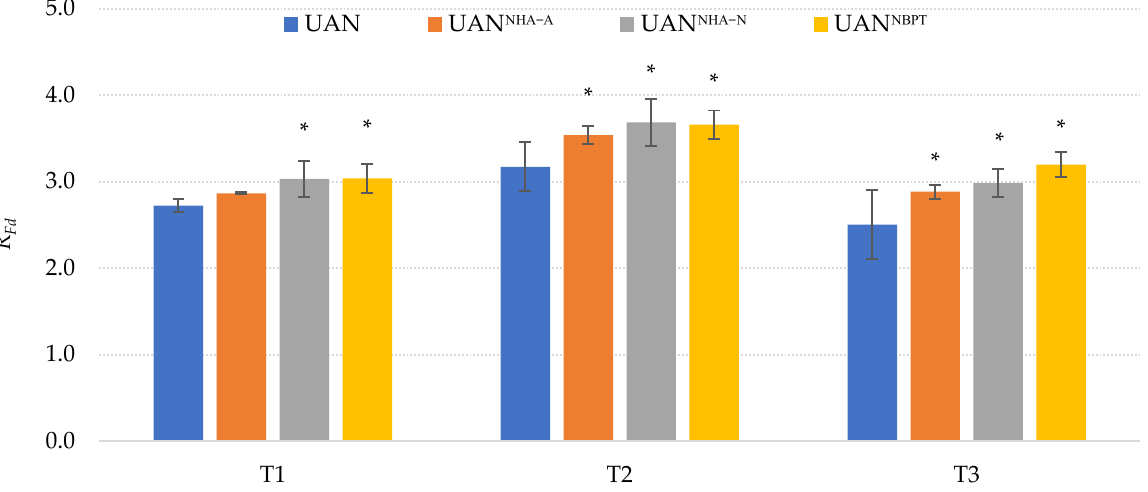
Figure 3. The effect of the UAN fertilizer with NHAs and NBPT on chlorophyll fluorescence decrease ratio ( R Fd ). The columns represent the mean ( n = 12); error bars present the mean standard deviation. The mean values marked with asterisk are significantly different ( p ≤ 0.05) from the treatment UAN by Tukey’s test (each of the terms was statistically evaluated separately).